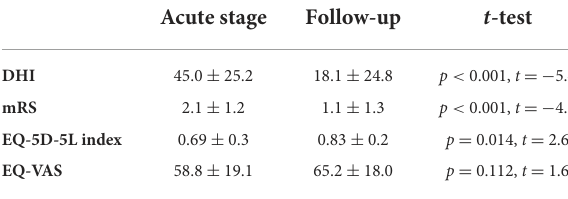
TABLE 1 Health-related quality of life (HRQoL), functioning, and symptom severity at acute stage and follow-up. Acute stage Follow-up t